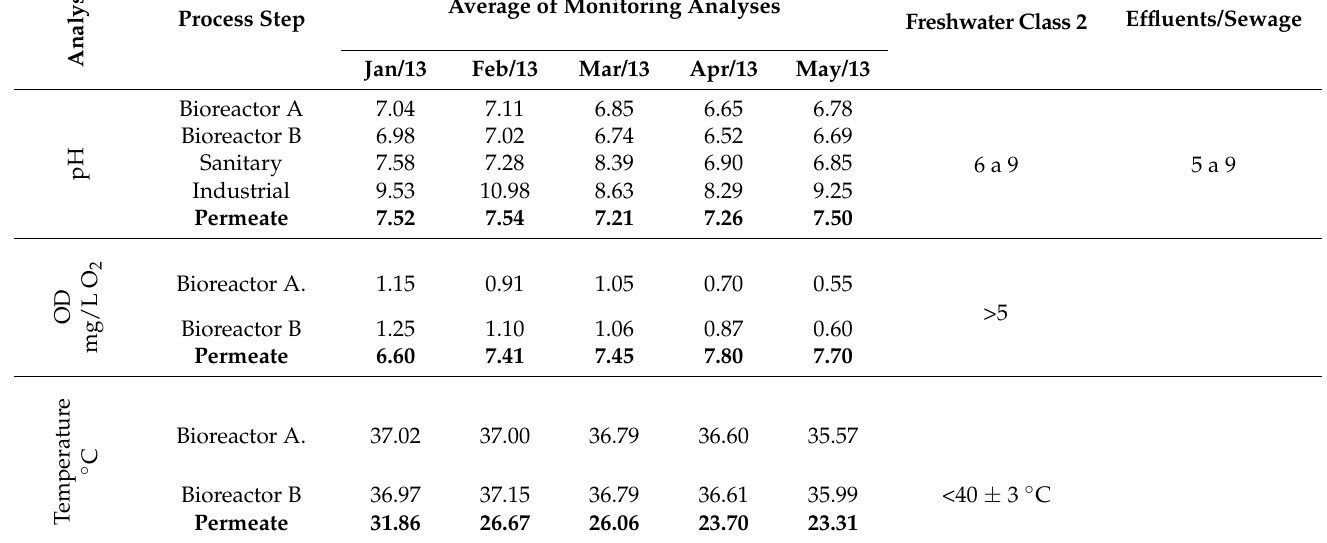
Table 3. Comparison between the results of each stage of the effluent treatment process according to the CONAMA standard